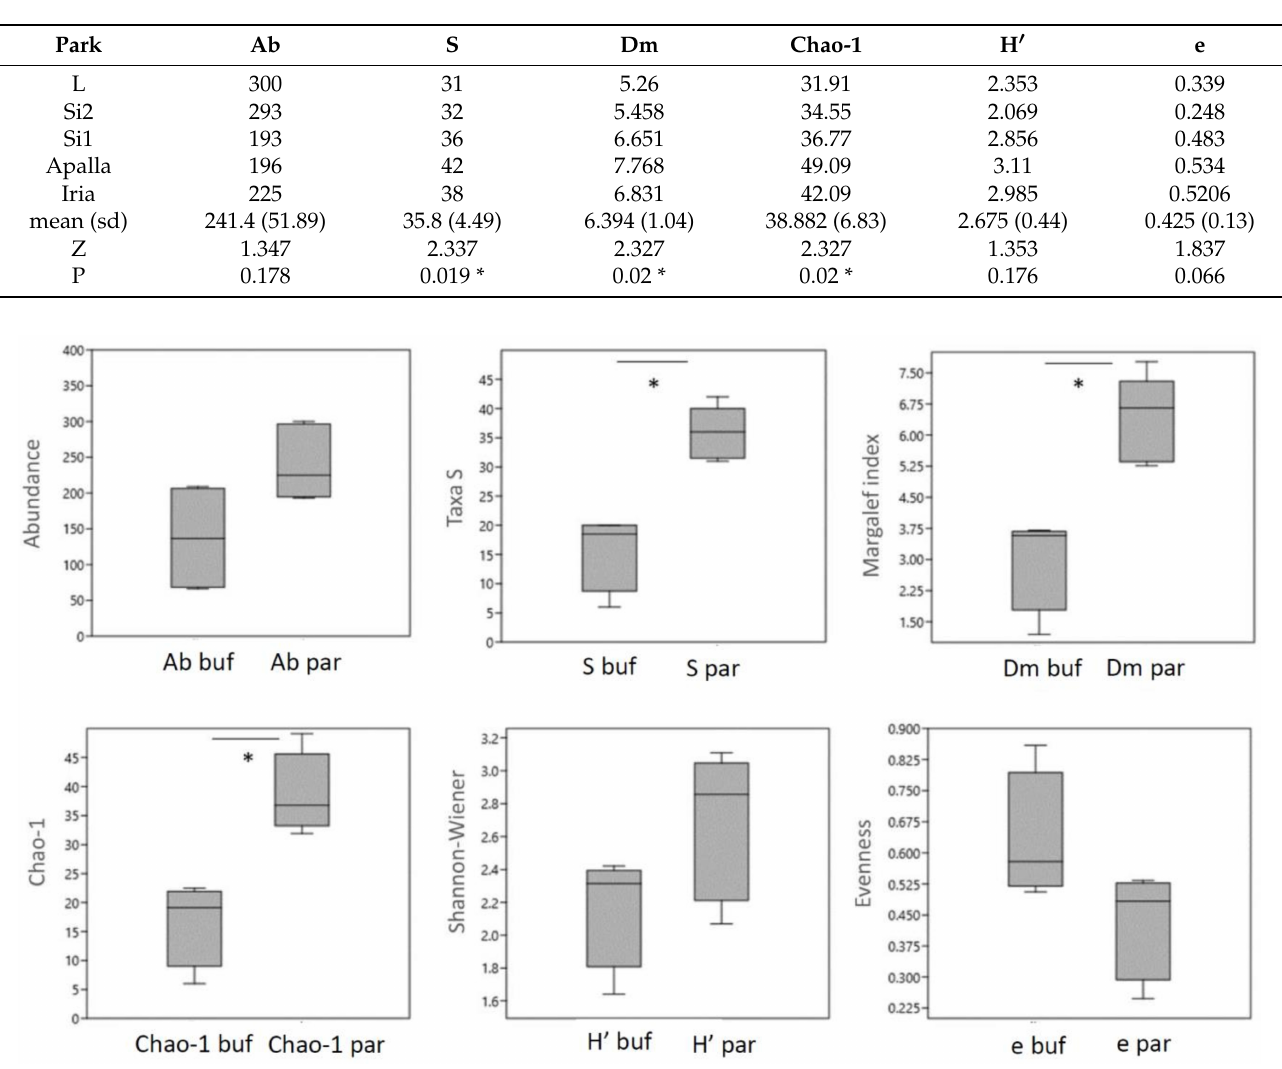
Figure 2. Boxplots with mean values (and standard deviation) for the uni-variate metrics of diversity. Ab, abundance index; S, species richness; Dm: Margalef index (normalized species richness); Chao-1, Chao-1 richness estimator; H (cid:48) , Shannon-Wiener diversity index; e, evenness; buf, buffer; par, park. See Methods for details. *: p <